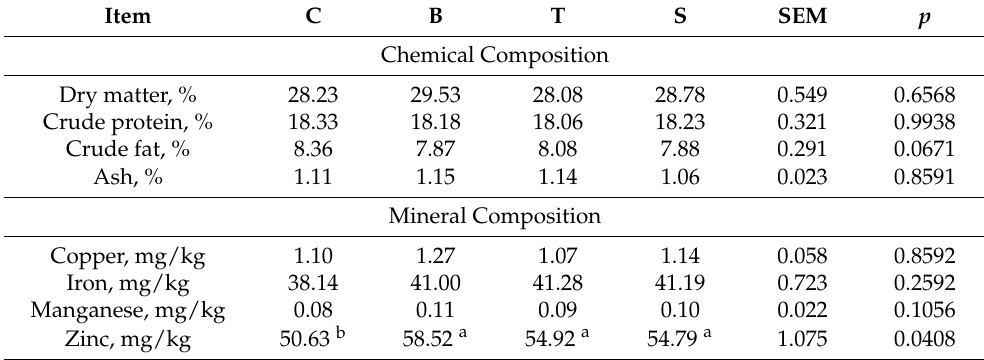
Table 3. Effect of dietary plants on chemical and mineral composition of chicken meat. Item C B T S